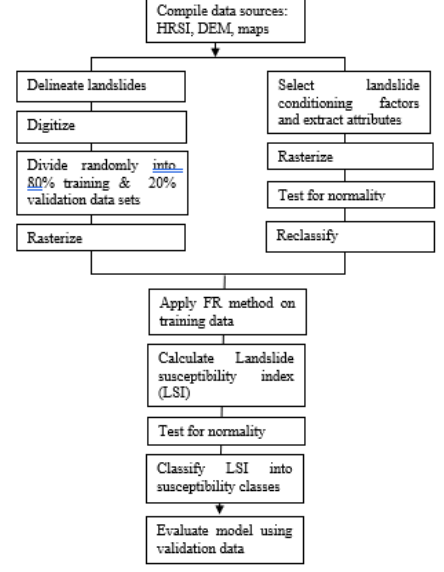
Figure 2. General work flow for landslide susceptibility assessment using frequency ratio